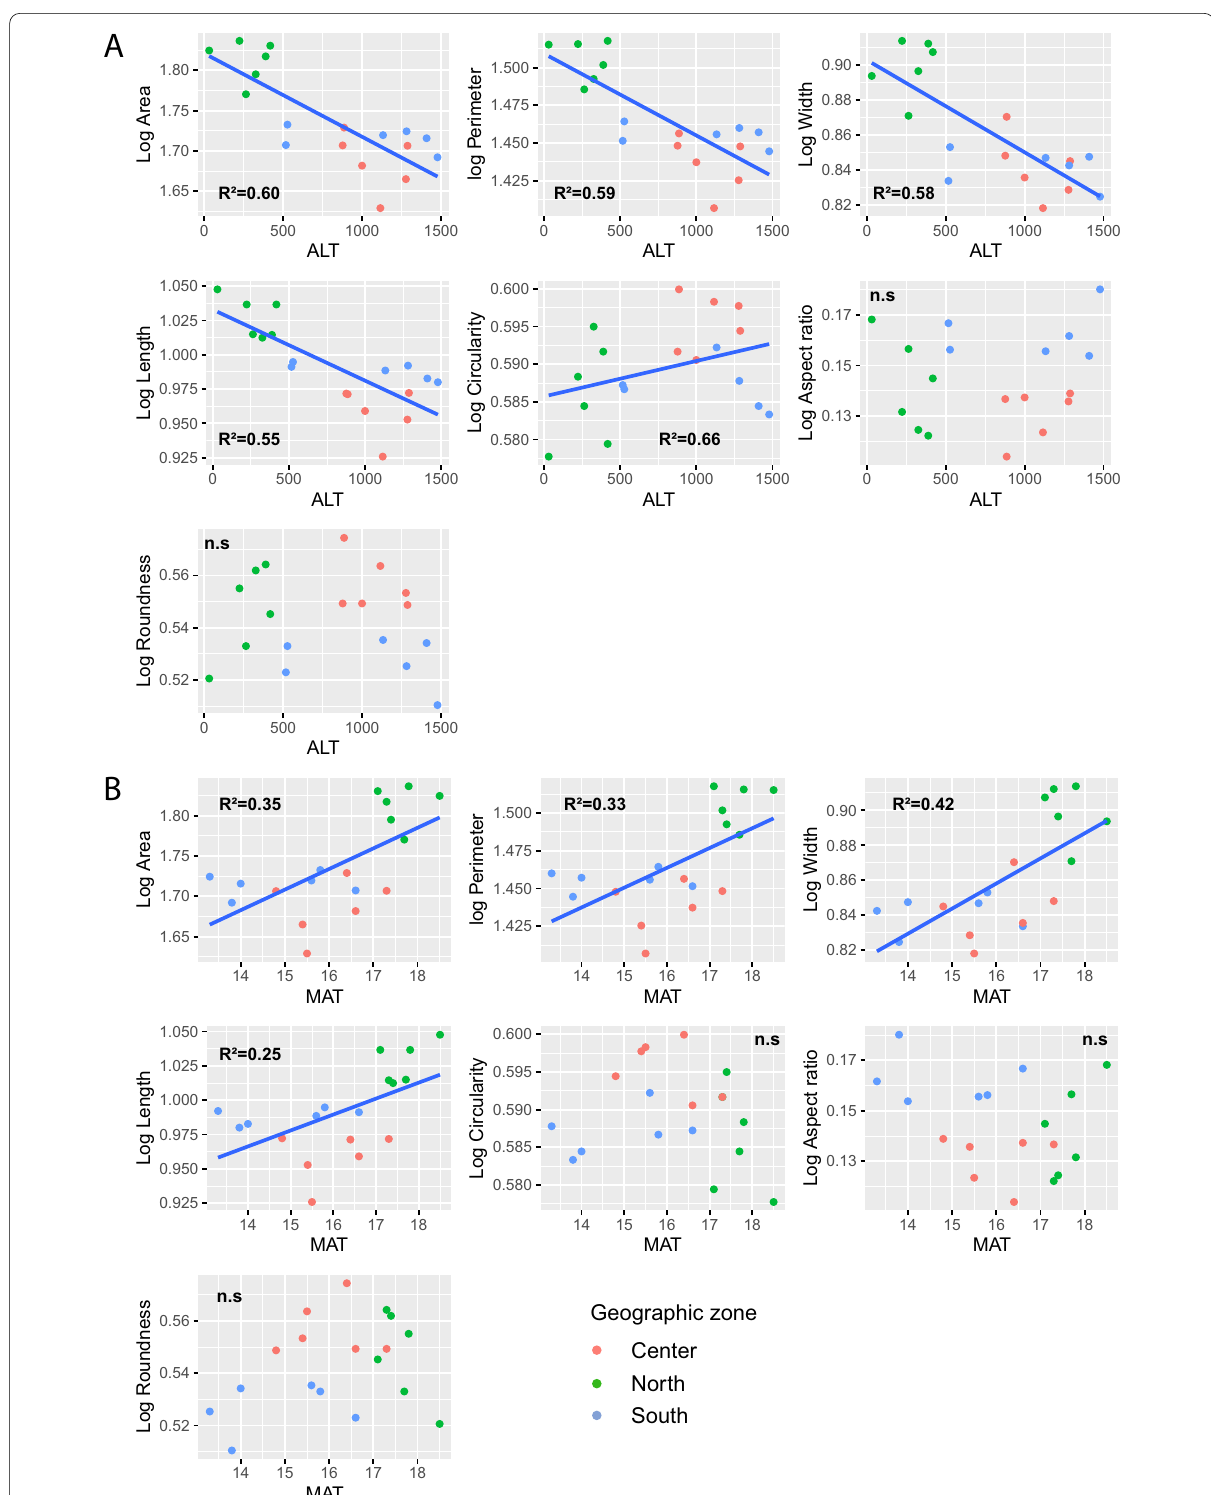
Fig. 3 Relationship between carob seed traits and A altitude, B MAT, C MAP, D MTCM, and E MTWM. n.s.